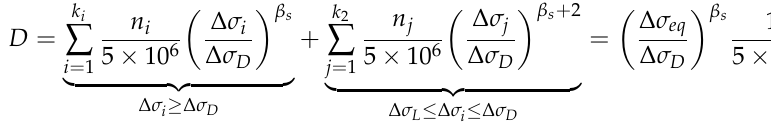
Figure 5. Time history of cable force for cable 1 and cable 28.